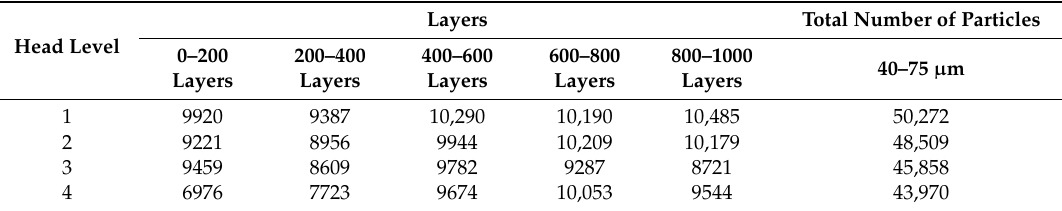
Table 14. Variation in the number of fine particles percolated with the 50% fine particle content (40–75 µ